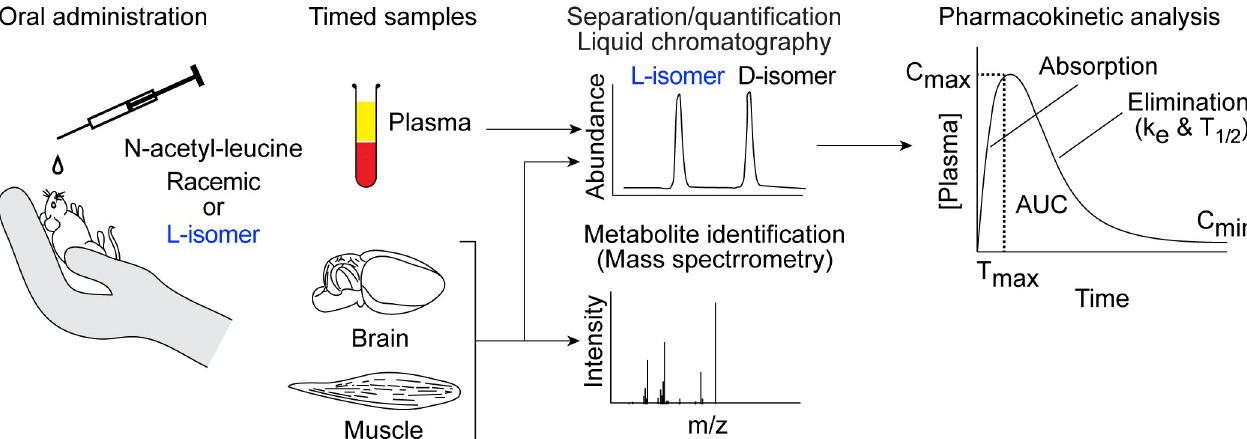
Fig 2. Schematic outlining the experimental procedure. Male mice were orally administered N-acetyl-leucine as either the racemate (50% each enantiomer) or purified L-enantiomer (2.6% D-enantiomer and 97.4% L-enantiomer). At specific times (0.25 to 8 h) after administration, blood was taken, plasma was separated and quantified by chiral liquid chromatography/mass spectrometry. Plots of the plasma concentration of each enantiomer over time were used to visualize pharmacokinetics and a noncompartmental model was used to calculate the pharmacokinetic parameters C max (maximum peak concentration), T max (time to reach C max ), k e (first order elimination rate constant), T 1/2 (half-life) and AUC (area under the curve). Samples of brain and skeletal muscle were also taken at specific times and used to determine compound distribution and to search for metabolites with high-resolution mass spectrometry. https://doi.org/10.1371/journal.pone.0229585.g002 and Table 1) and AUC of 75800 h � ng/mL versus 2560 h � ng/mL (Fig 5D and Table 1). The elimination rate was similar for both enantiomers, indicated by the linear and parallel curves on a semilog graph (Fig 3B) using a noncompartmental model giving a k of 2.2 h -1 for the D- e values enantiomer and 2.8 − 1 h for L-enantiomer (Fig 5C and Table 1), with corresponding T 1/2 of 0.31 h and 0.40 h (Fig 5E and Table 1). The D-enantiomer remained detectable until 8 h